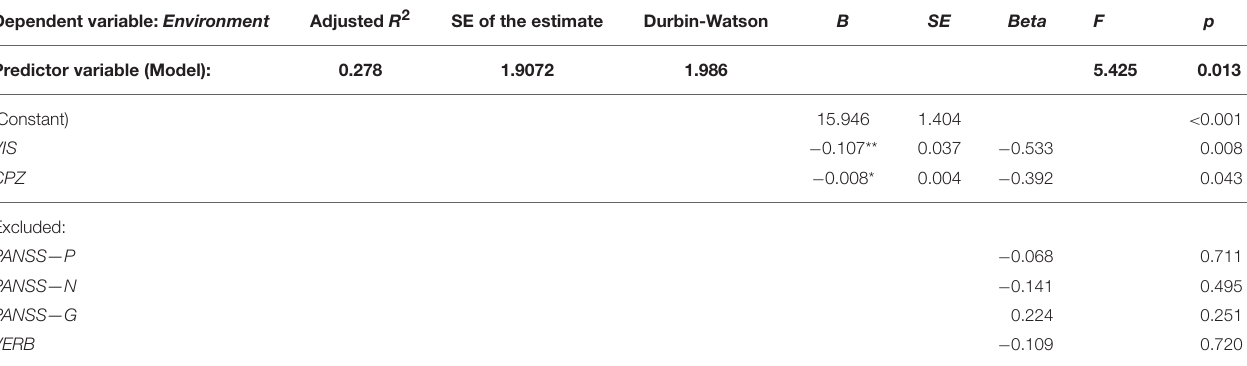
TABLE 8 | Regression model of clinical and neuropsychological variables (predictors) on perceived quality of Environment (dependent variable). Dependent variable: Environment Adjusted R 2 SE of the